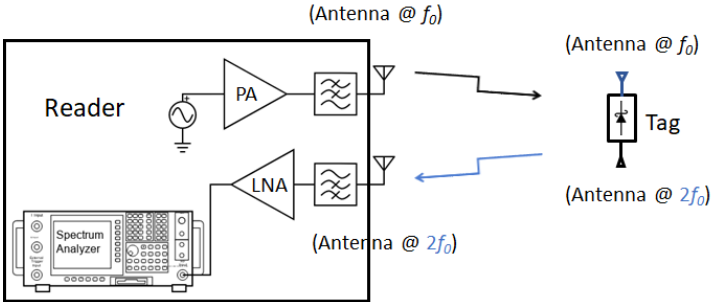
Figure 9. Schematic diagram of a chipless harmonic RFID tag and reader system with two